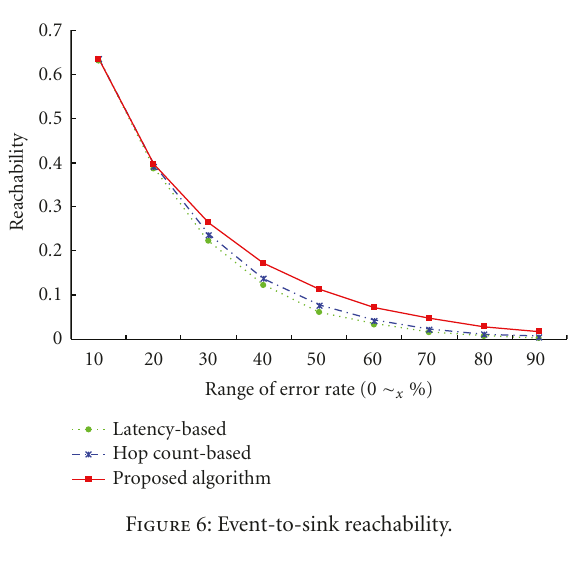
Figure 8: Total number of